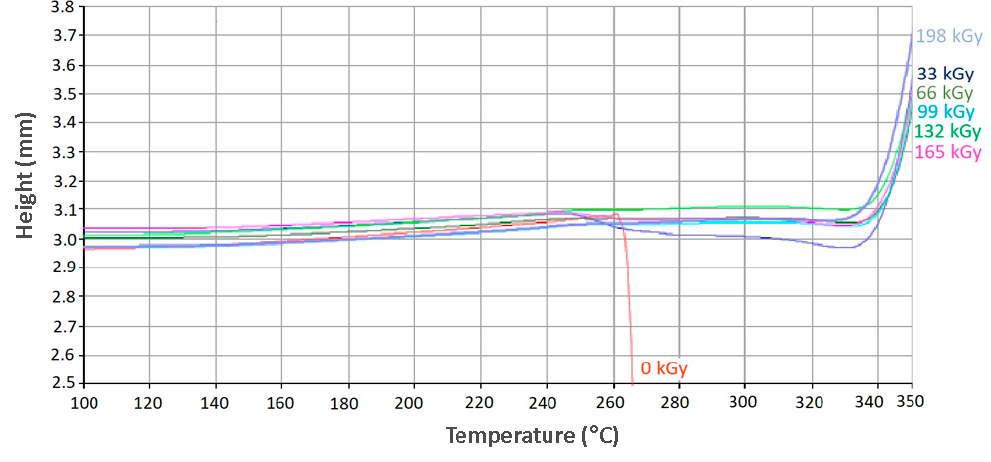
Figure 12. Thermo-mechanical analysis (PA 66).